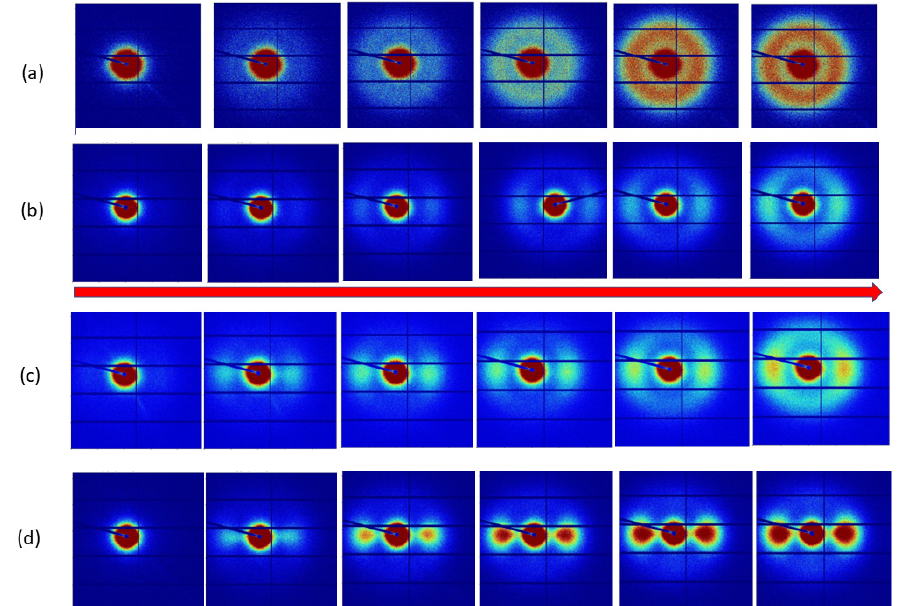
Figure 6. SAXS patterns obtained at approximately 1 s intervals at the first viewing port for injections at ( a ) 250 ◦ C, ( b ) 210 ◦ C, ( c ) 205 ◦ C, and ( d ) 190 ◦ C. The flow in the mould cavity is horizontal as indicated by the horizontal arrow. Time increases from left to right. The intensity mapping is constant within each sequence. The horizontal and vertical dark lines correspond to insensitive areas in the detector as it is made up of rectangular elements. The dark spot in the centre of the pattern corresponds to the area of the detector blocked by the beam stop, and the angled black line corresponds to the mount for the beam stop. The SAXS detector cover the |Q| range from 0.002 Å − 1 to 0.125 Å − 1 . The data shown here are the raw experimental data; no background has been subtracted so that the quality of the data may be easily judged.